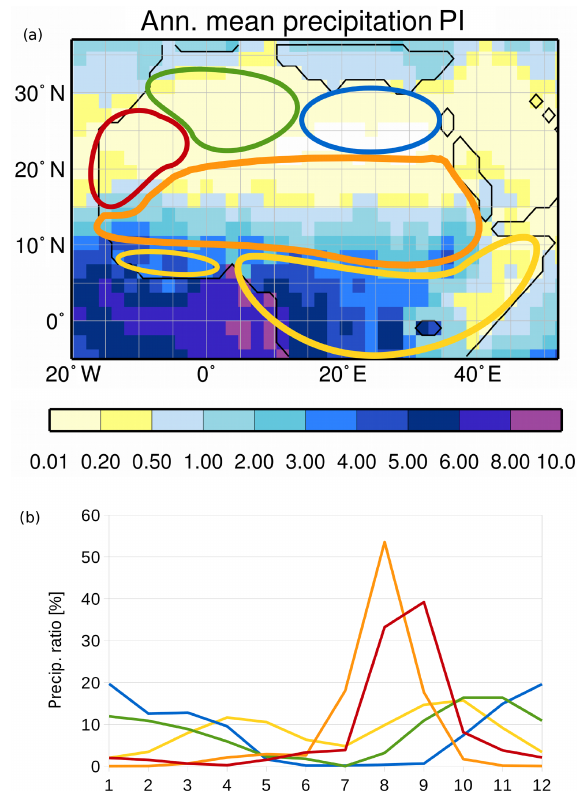
Figure 7. (a) Simulated preindustrial annual mean precipitation (mmd − 1 ) and major rainfall regimes; (b) monthly preindustrial pre- cipitation ratio (%) in the different regimes, i.e. the ratio of monthly mean precipitation to annual mean